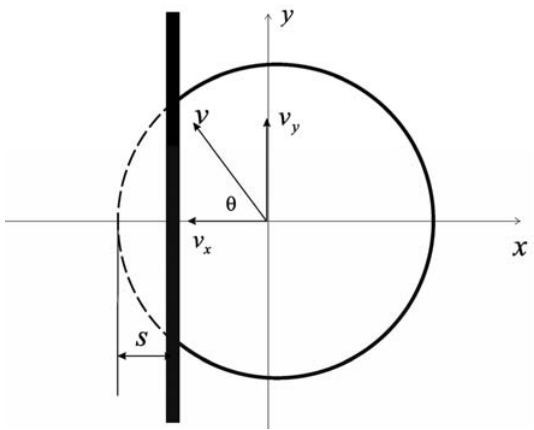
Fig. 2 Model of particle collision to the vertical